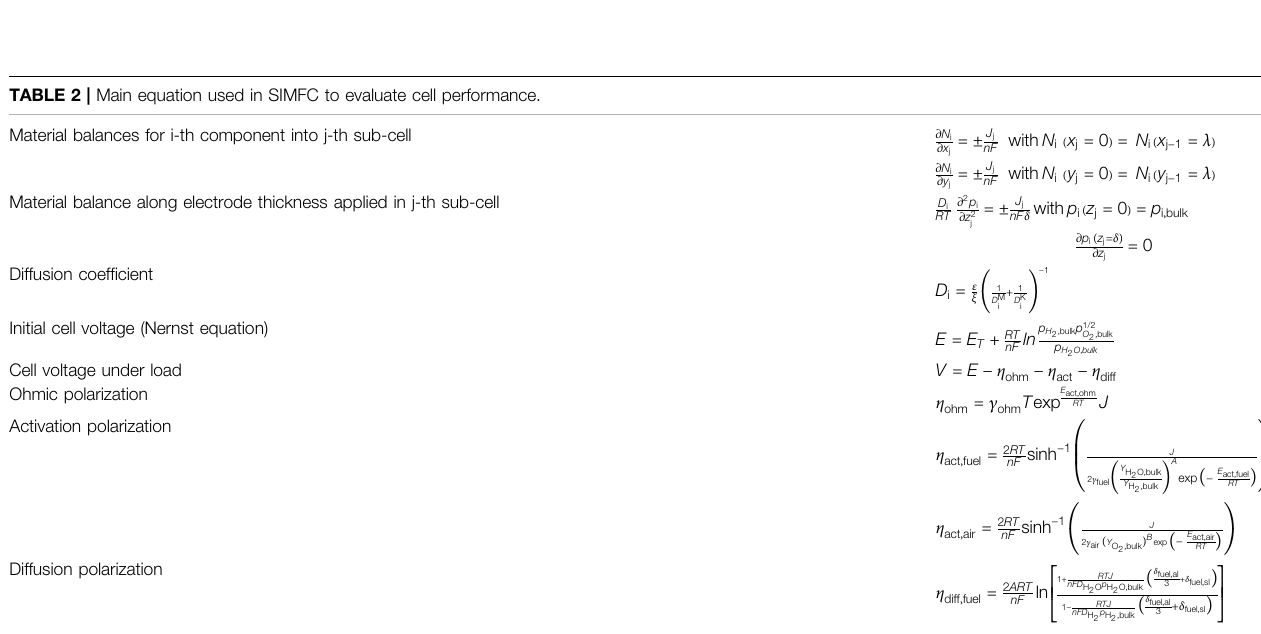
Frontiers in Energy Research |